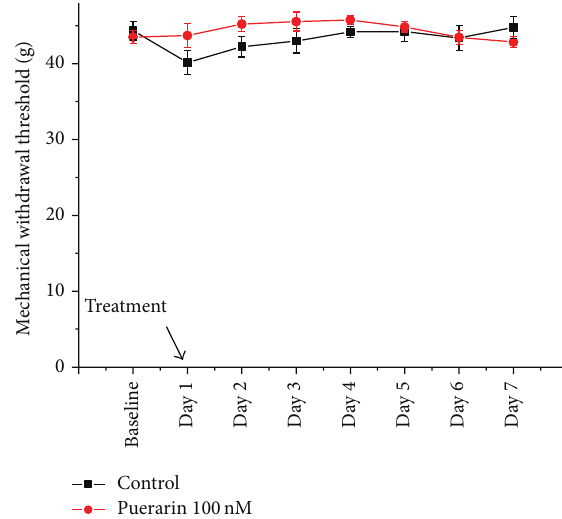
Figure 1: The effects of puerarin on mechanical stimulus test in normal rats. Normal rats received intrathecal 100 nmol puerarin or vehicle. The mechanical withdrawal thresholds (g) of the right hind paws were measured 60 min after drug administration. Data were presented as mean ± SEM. Each group consisted of 5 rats. At 100nM, puerarin did not affect mechanical withdrawal